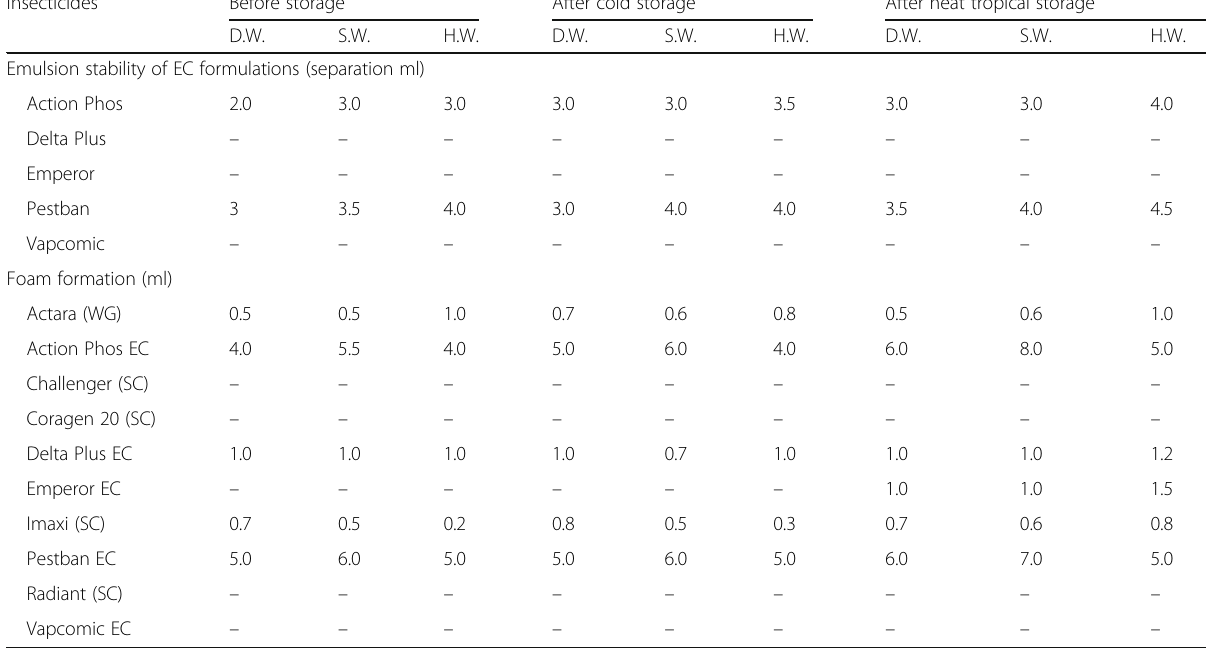
Table 2 Emulsion stability (EC formulations) and foam formation of the tested insecticides before storage, after cold, and heat tropical storage using distilled, soft, and hard water